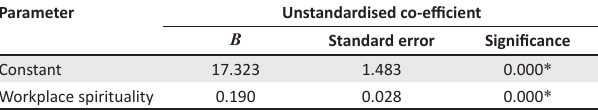
TABLE 2: Parameter estimates for workplace spirituality on employee mental